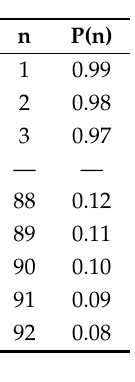
Table 1. Hypergeometric retry count